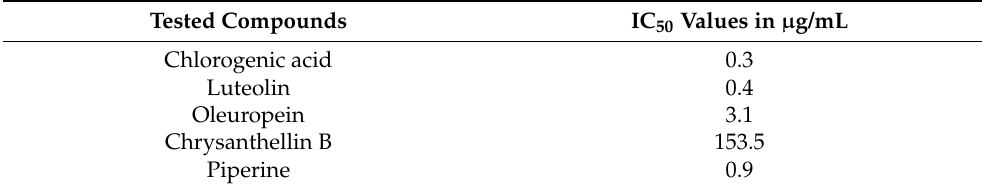
Table 3. IC 50 of five phytochemical compounds for α -glucosidase